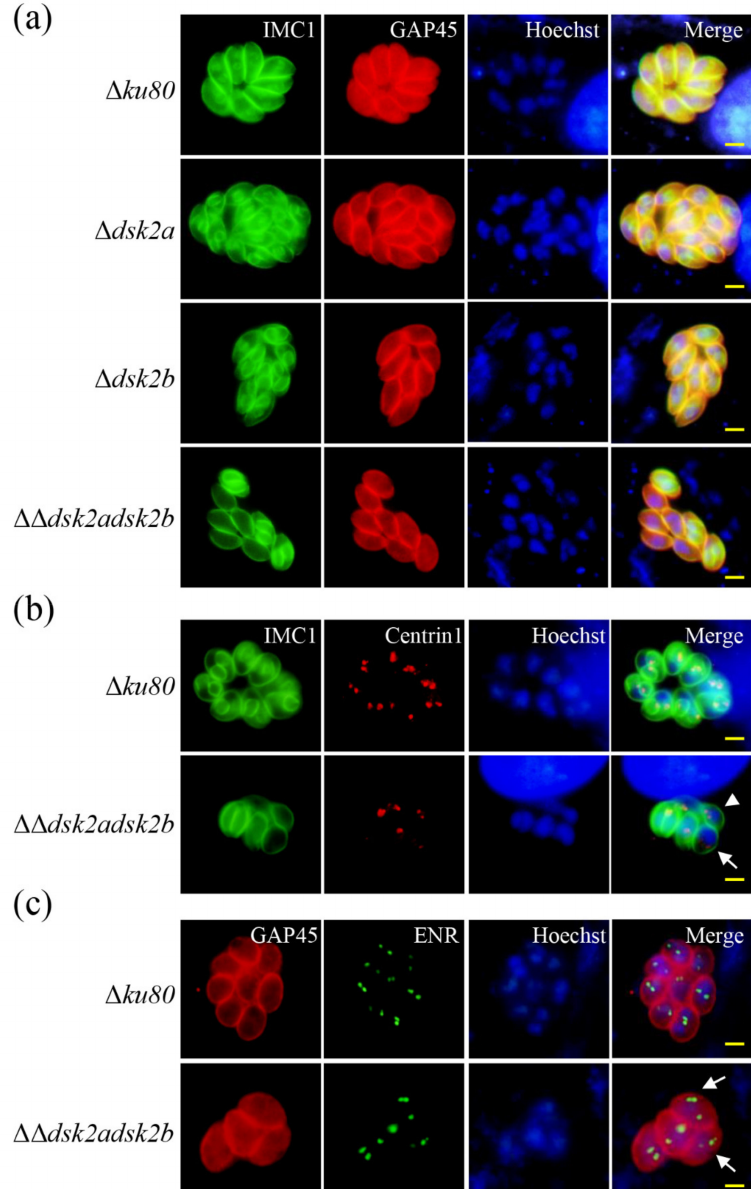
Figure 5. Deletion of DSK2s results in asynchronous replication of T. gondii . ( a ) IFA detected the division of ∆ ku80 , ∆ dsk2a , ∆ dsk2b and ∆∆ dsk2adsk2b . IMC1 was used to stain the daughter parasites. GAP45 was used to label the parental parasites. Scale bar: 2.5 µ m. ( b ) IFA detected the duplication of a centrosome in ∆ ku80 and ∆∆ dsk2adsk2b . Centrin1 was used to label the centrosome. White triangle indicates the tachyzoite in which the duplication of centrosome occurs before daughter IMC formation. Arrow indicates the tachyzoite in which the duplication of centrosome is asynchronous. Scale bar: 2.5 µ m. ( c ) IFA detected apicoplasts in ∆ ku80 and ∆∆ dsk2adsk2b . ENR was used to label apicoplasts. Arrows indicate tachyzoites with more than two apicoplasts. Scale bar: 2.5 µ